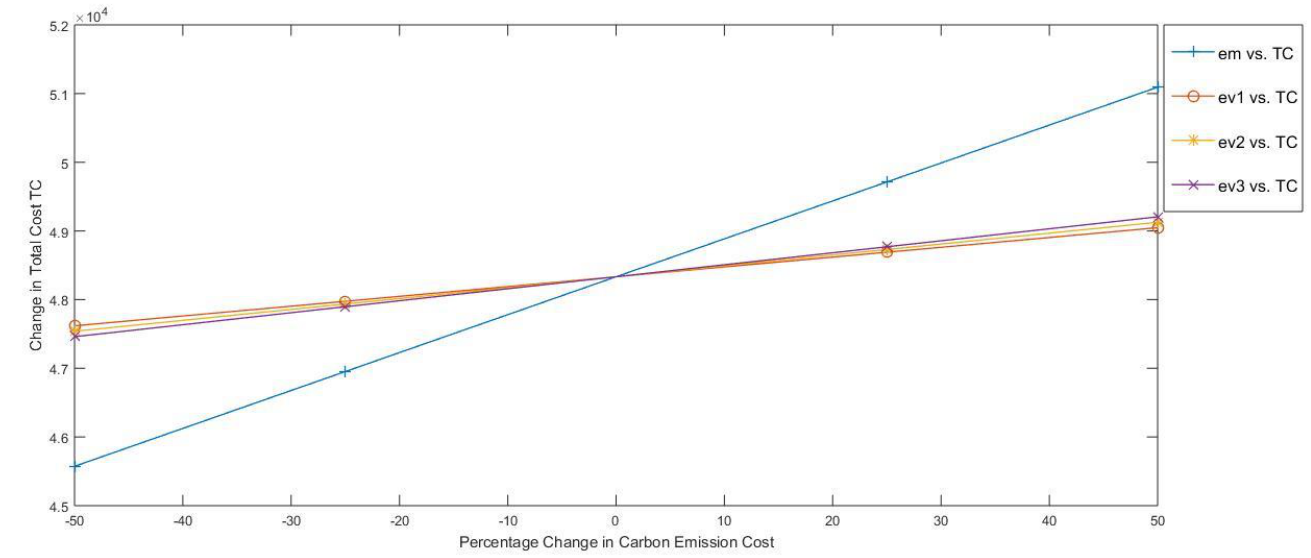
Figure A2. Sensitivity analysis graph for carbon emission and total cost.